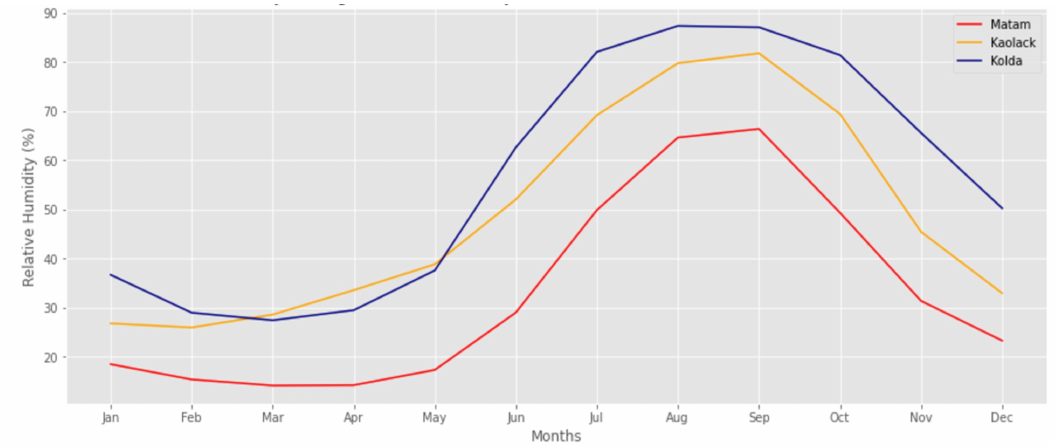
Figure 10. Monthly average Relative Humidity for Matam, Kaolack and Kolda